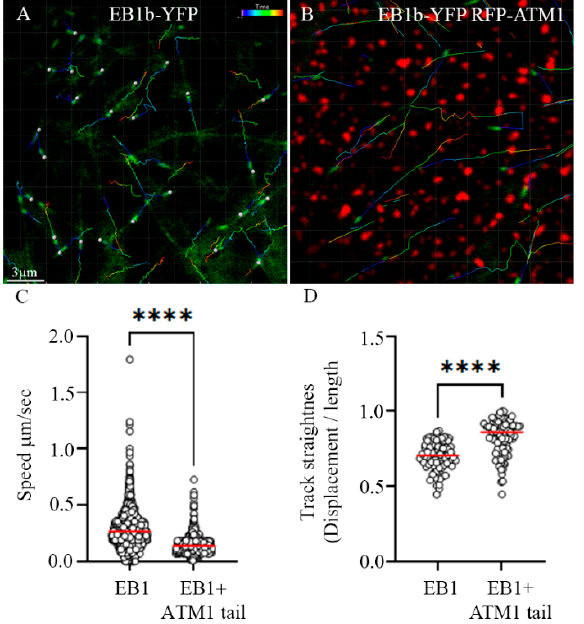
Figure 3. Changes in elongation rate and track straightness of MTs in the presence of overexpression of ATM1 IQ-tail . EB1b-YFP was expressed alone ( A ), or in the presence of mCherry-ATM1 IQ-tail ( B ) in N. benthamiana leaves. Time-lapse movies were acquired (50 frames, frame/1s) and image analysis was done using Imaris. Scale bar = 3 μ m. ( C ) EB1b speed was calculated from all tracks every 1 s. ( D ) Track straightness was calculated by dividing the displacement by the total length. Calculations were performed for ten independent cells of each expression combination. The color code show the age of the track; start = blue, end = red. Differences were determined by t -test **** p < 0.0001.